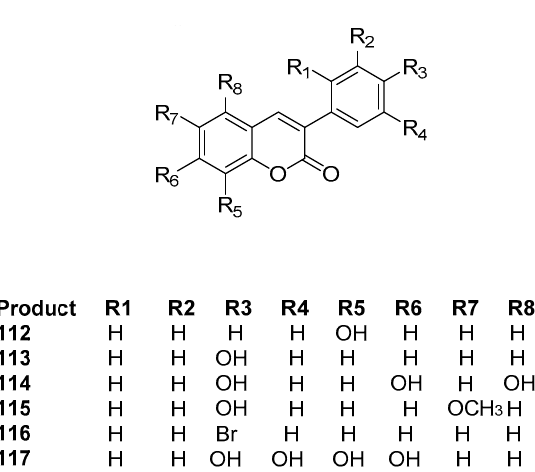
Figure 43. General structure of compounds 112–117 .